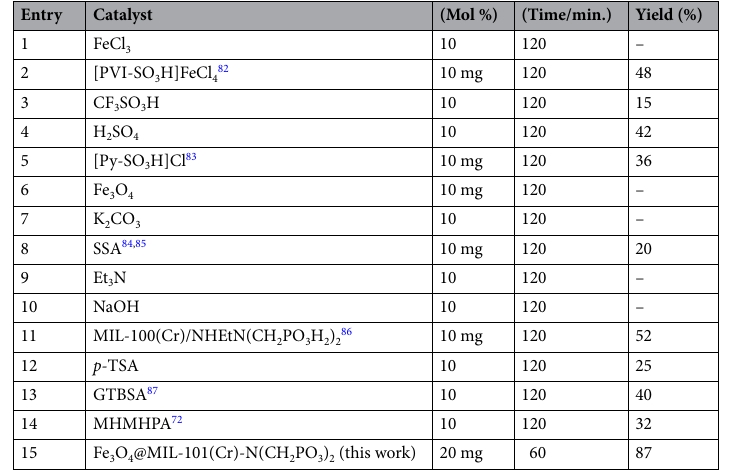
Table 4. Compare of various catalyst for the synthesis of pyrazolo [3,4- b ] pyridine derivatives in comparison with Fe